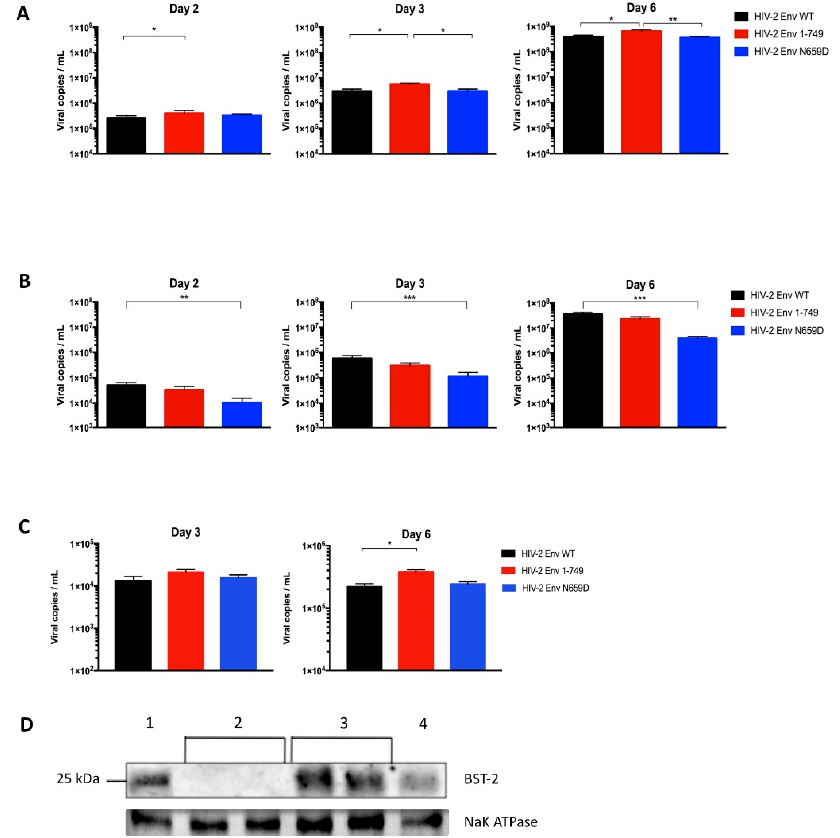
Figure 5. ( A ) Absolute quantification of the HIV-2 Env WT, Env 1–749 and Env N659D viral release capacity from BST-2-depleted H9 cells at two, three and six days post-infection; ( B ) Absolute quantification of viral particles released from H9 cells transduced with pseudotyped viruses that encoded Cas9 protein and a single guide RNA (sgRNA) sequence recognizing an intron sequence. The replicative capacity of the three viruses remained equivalent to the viral release assay using H9 cells that expressed BST-2 (Figure 3A); ( C ) Absolute quantification of viral release capacity from transfected HEK293T cells, which do not express BST-2, at three and six days post-transfection; ( D ) BST-2 expression in those cells was verified by immunoblotting proteins from H9 cells lysates (1), two different populations of BST-2-depleted H9 cells (2), two different populations of H9 cells transduced with pseudotyped viruses that encoded a sgRNA sequence recognizing an intron sequence (3) and Jurkat cells (4). Graphs present the number of viral copies in a logarithmic scale. Error bars indicate mean ± SD for n = 4 independent experiments (except for the panel C , n = 3). Statistical tests give statistical significance with a p < 0.05 (*), p < 0.01 (**) or p < 0.001